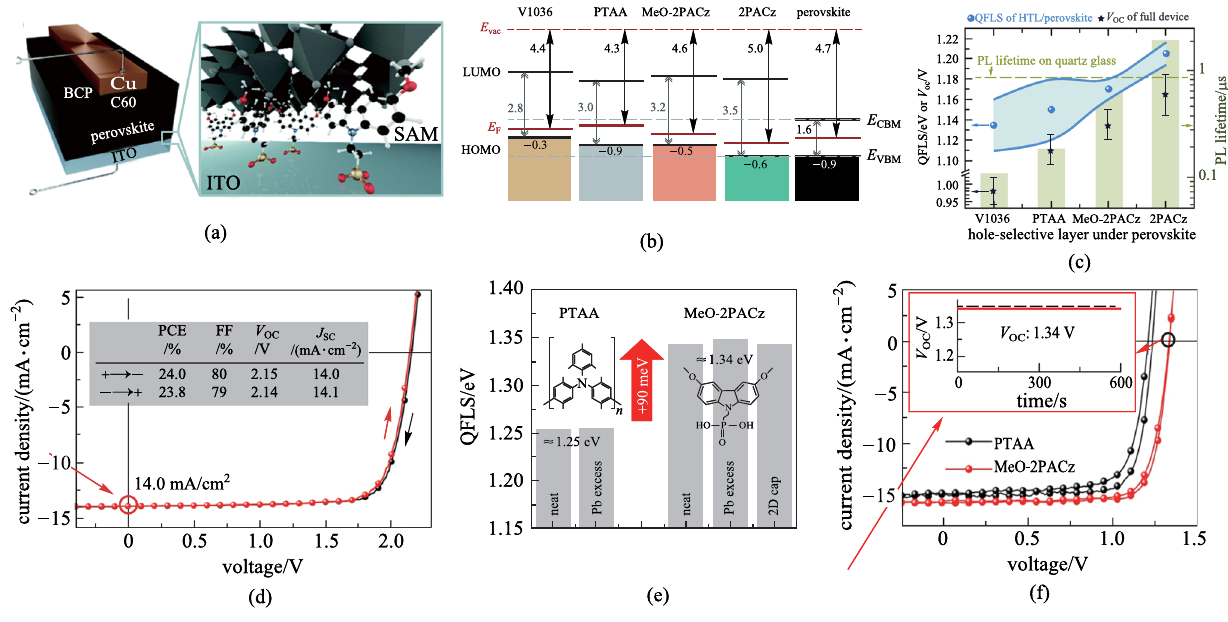
Fig. 7 a Schematic of the investigated device structure based on MeO-2PACz . b Schematic representation of the band edge positions of the investigated HTMs based on values from ultraviolet photoelectron spectroscopy (UPS), referenced to the vacuum level. c Summary of abs pho- toluminescence and time-resolution photoluminescence measurements. d J – V characteristics of the champion perovskite-organic tandem cells based on MeO-2PACz. e Splitting of the quasi-Fermi-level splitting (QFLS) in the case of varied HTMs. f J – V characteristics for champion wide-gap perovskite subcells with a 2D capping layer. a – c Reprinted with permission from Ref. [61]. Copyright 2019, Royal Society of Chemis- try. d – f Reprinted with permission from Ref. [67]. Copyright 2022, Springer